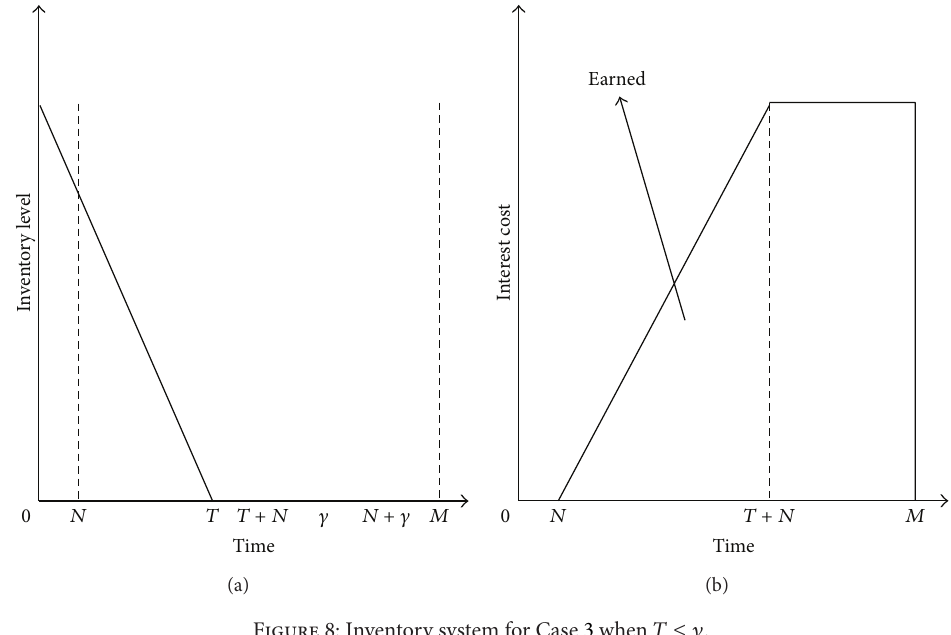
Figure 8: Inventory system for Case 3 when 𝑇 ≤ 𝛾